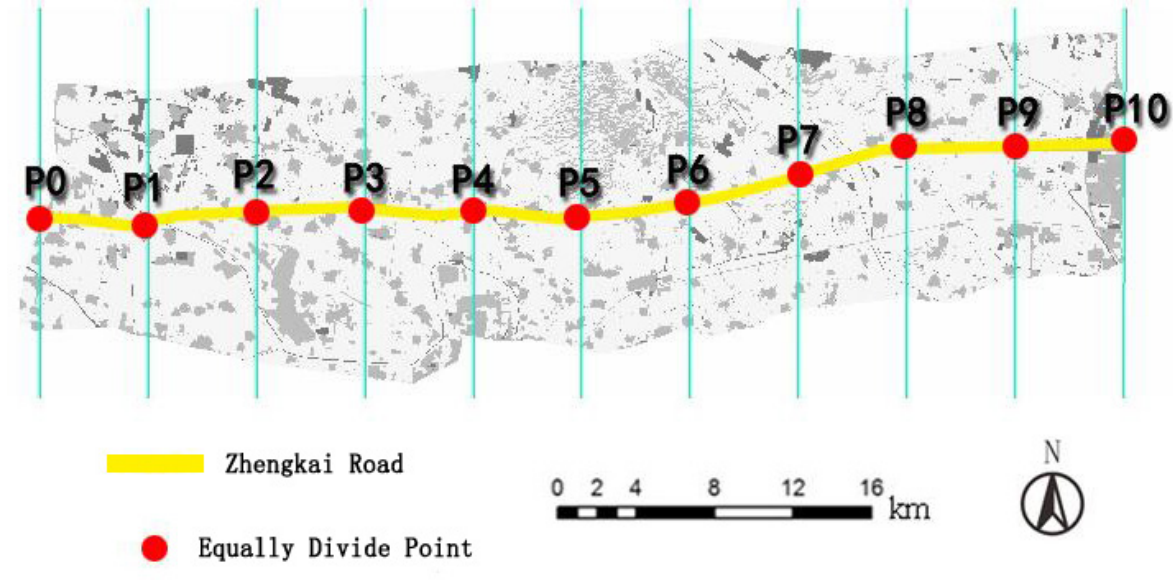
Figure 2. Gradient division of study